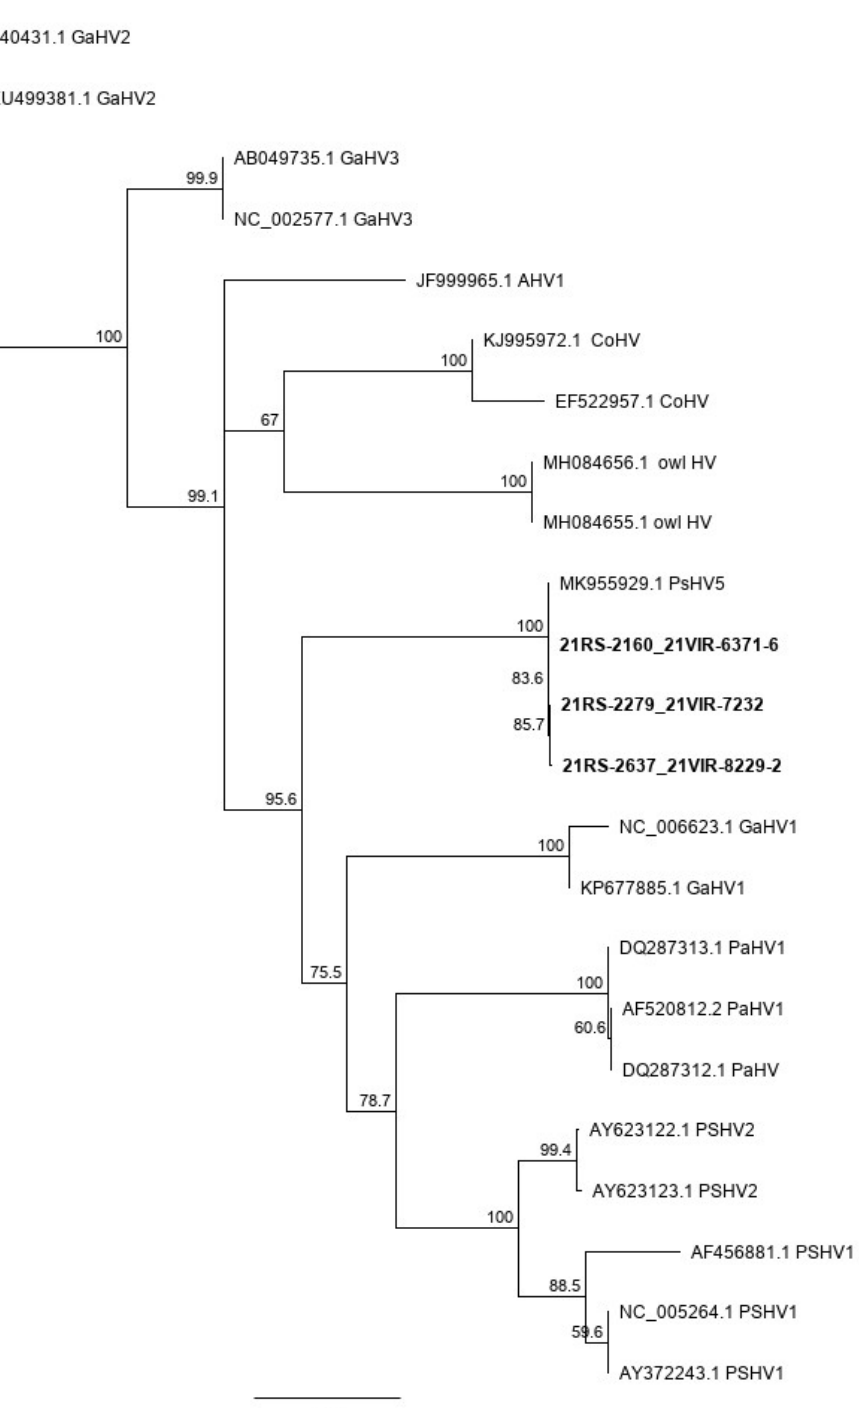
Figure 6. Phylogenetic tree based on the nucleotide sequences of the DNA polymerase gene of avian herpesviruses. The tree was constructed using the maximum likelihood method with 1000 bootstrap replicates and implemented by MEGA X. The PsHV-5 sequences of the present report are identified in bold. The scale bar indicates the number of substitutions per site. Acronym legend: GaHV2 ( Gallid herpesvirus 2 ); GaHV3 ( Gallid herpesvirus 3 ); AHV1 ( Anatid herpesvirus 1 ); CoHV ( Columbid herpesvirus 1 ); owlHV ( Strix uralensis herpesvirus ); PSHV5 ( Psittacid herpesvirus 5 ); GaHV1 ( Gallid herpesvirus 1